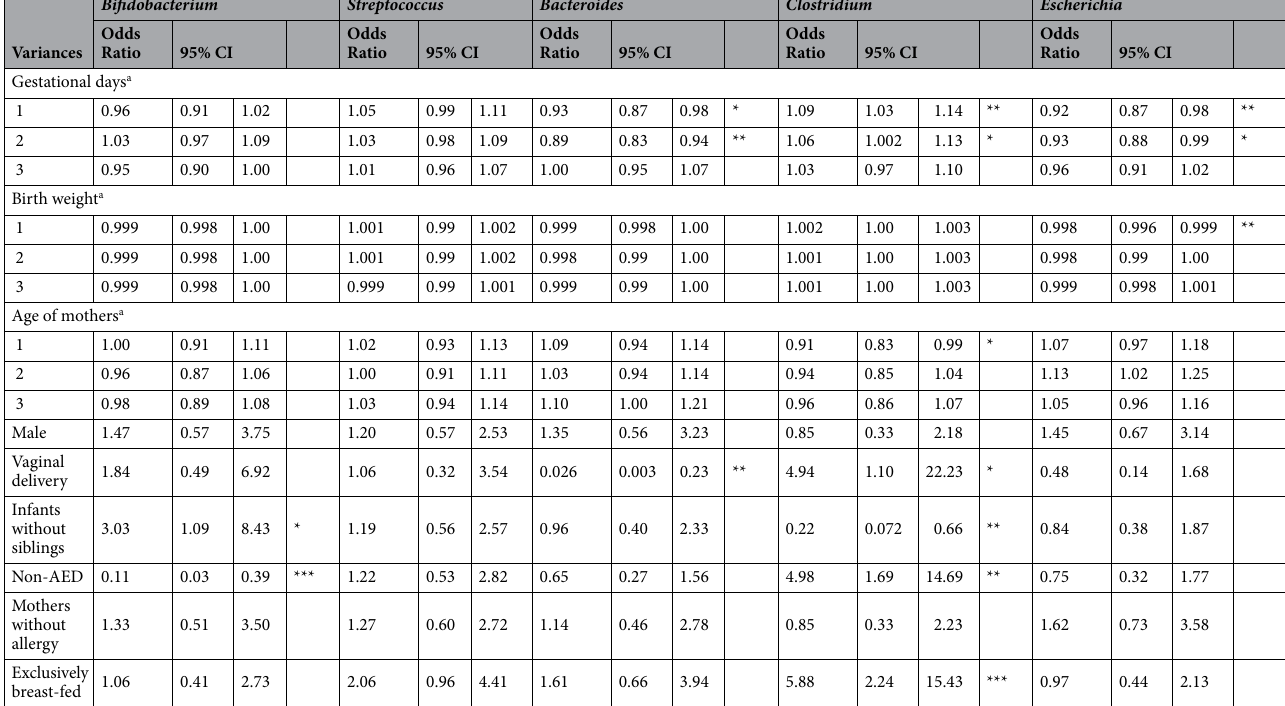
Table 2. Influence of background factors of the mother and child at 1 month on occupancies of the five most dominant bacterial genera in the intestinal microbiome of the infant. The bacterial genera are shown from left to right in the order of higher occupancy (mean). For the continuous variables ( a gestational age at birth, birth weight, and maternal age), occupancy was classified from 1 to 4 in ascending order from low occupancy with the occupancy of each bacterial species rounded to four decimal places. For the high occupancy group (group 4), a multinomial logistic regression analysis was performed as the category standard and the occupancy was classified into two groups based on the median for each genus for the logistic regression analysis for categorical variables. The odds ratio and 95% confidence interval were calculated using the logistic regression analysis and the multinomial regression analysis. The significance level was set at 5%. * p < 0.05, ** p < 0.01, *** p <